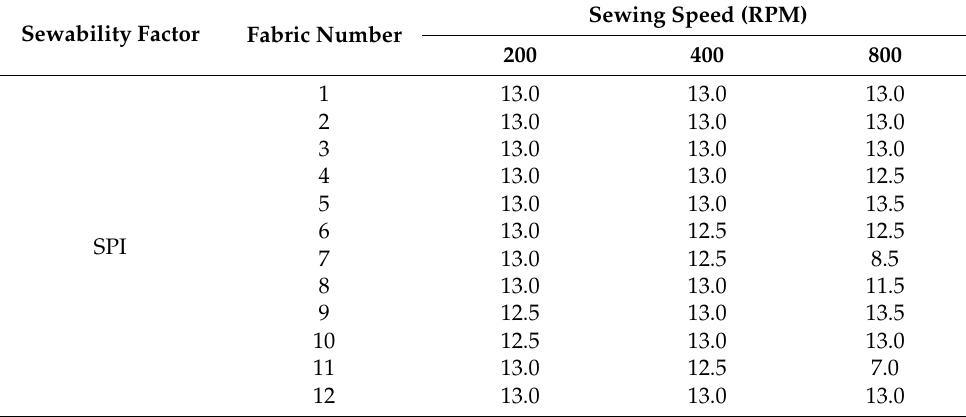
Table 4. Sewability of the lock stitch sewn parts on each fabric according to the sewing